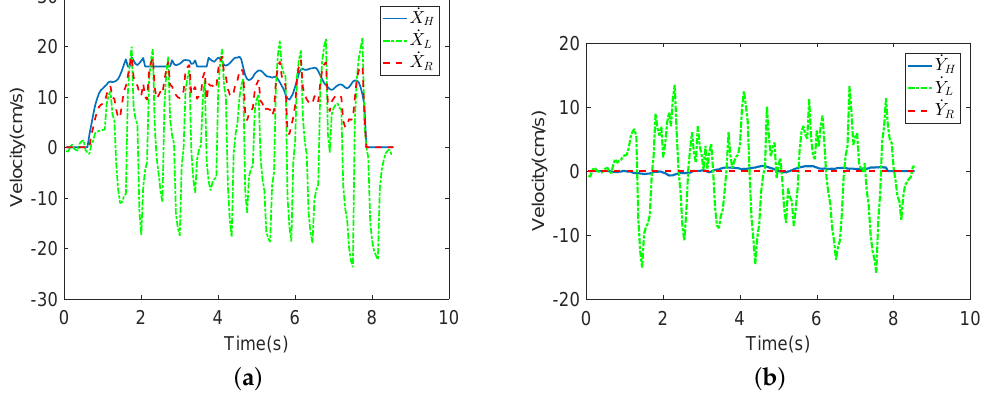
Figure 17. The results of the comparative compliance control experiment. ( a ) Admittance control experiment. In this experiment, the user goes straight with the robot. ( b ) Comparison of the interactive forces of the proposed coordinated motion fusion-based compliance control algorithm and admittance